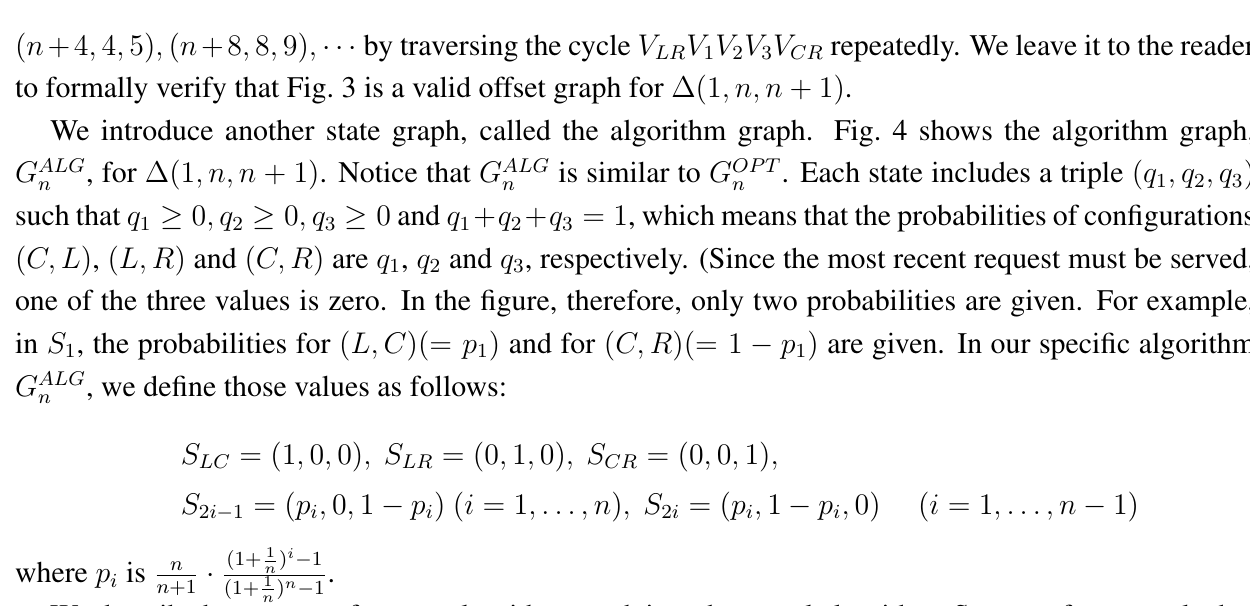
Figure 4 . State diagram of the